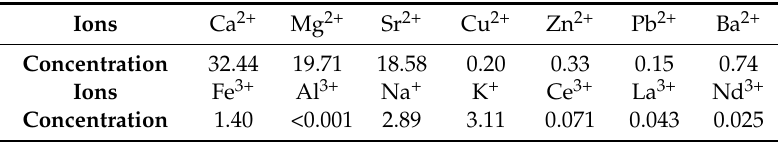
Table 1. Metal ion concentration in practical flotation pulp (mg/dm 3